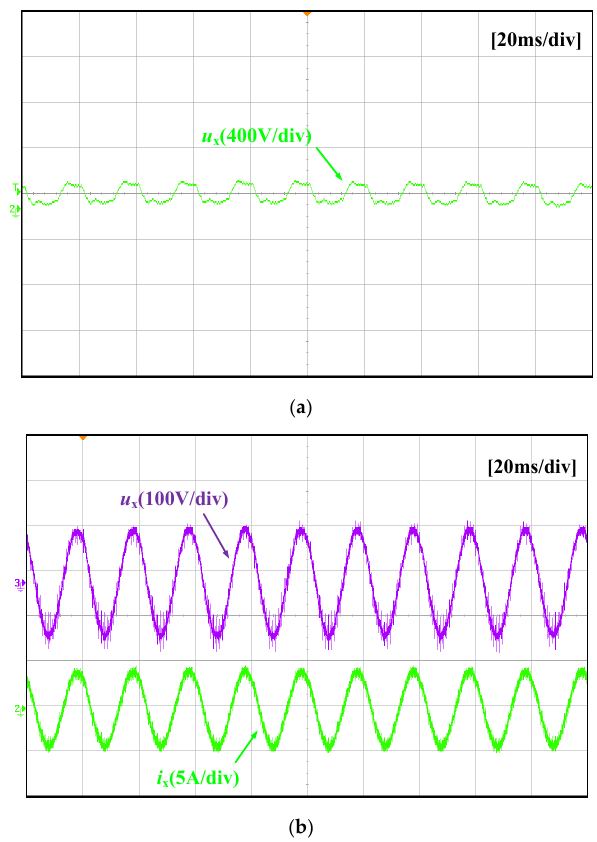
Figure 35 . Experimental result of the output voltage. Figure 35. Experimental result of the output voltage. Additionally, a comparison of the experimental results for different MMC topologies under enlarged output conditions when λ = 0.5 is presented in Figure 36. As illustrated, Figure 36a is the output voltage waveform of traditional MMC topology with trapezoidal modulation, while Figure 36b is the output waveforms of the proposed MMC topology with trapezoidal modulation. As it is observed from Figure 36, the output waveforms can be significantly improved by the proposed topology.